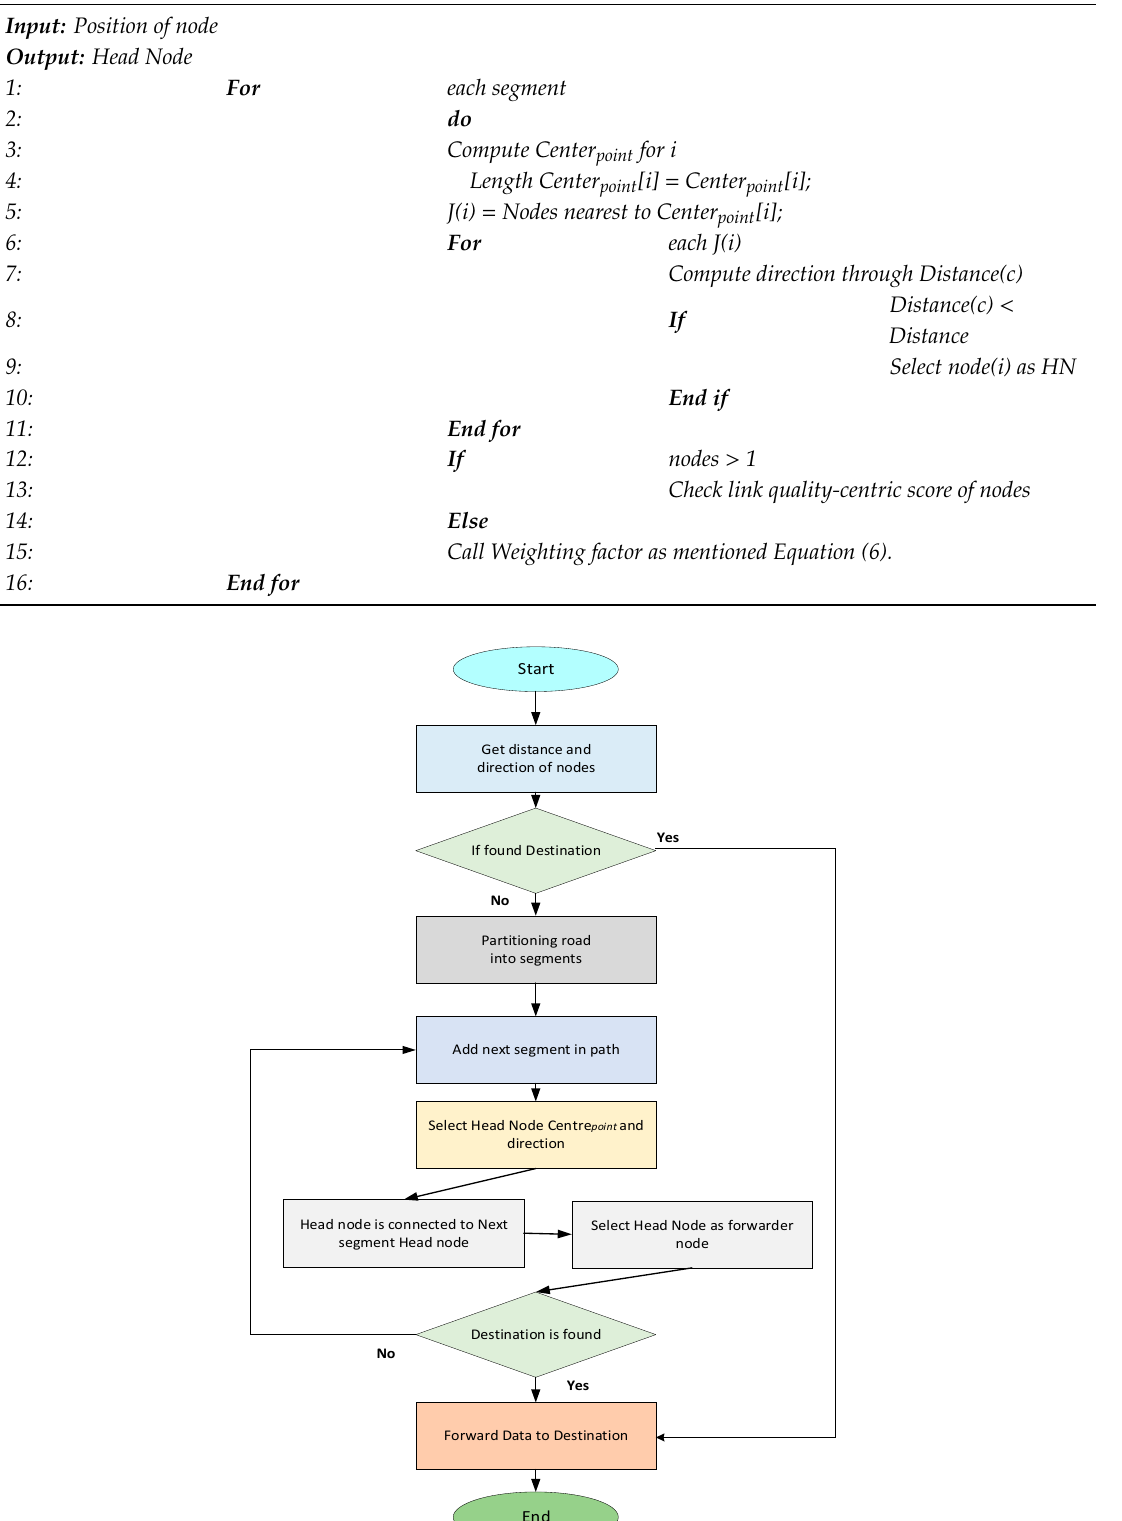
Algorithm 1: Head Node selection.